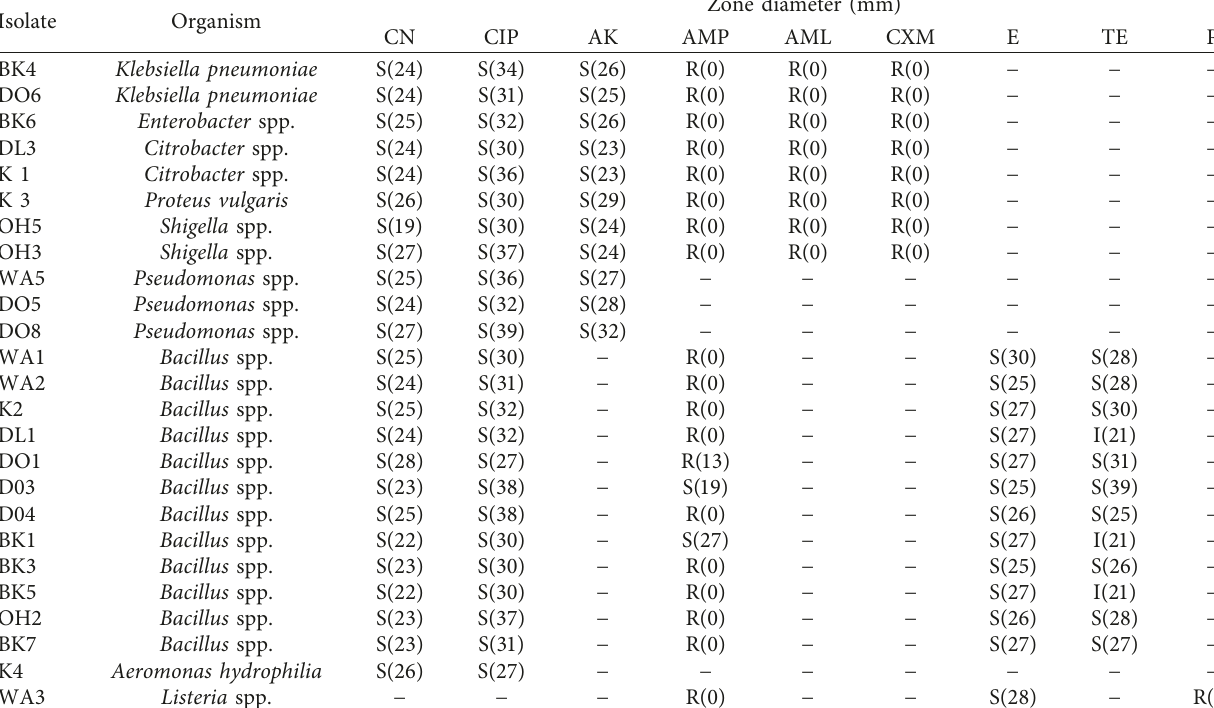
Table 6: Zones of inhibition (mm) of antibiotics against isolates and corresponding susceptibility and resistance of isolates to antibiotic. Isolate